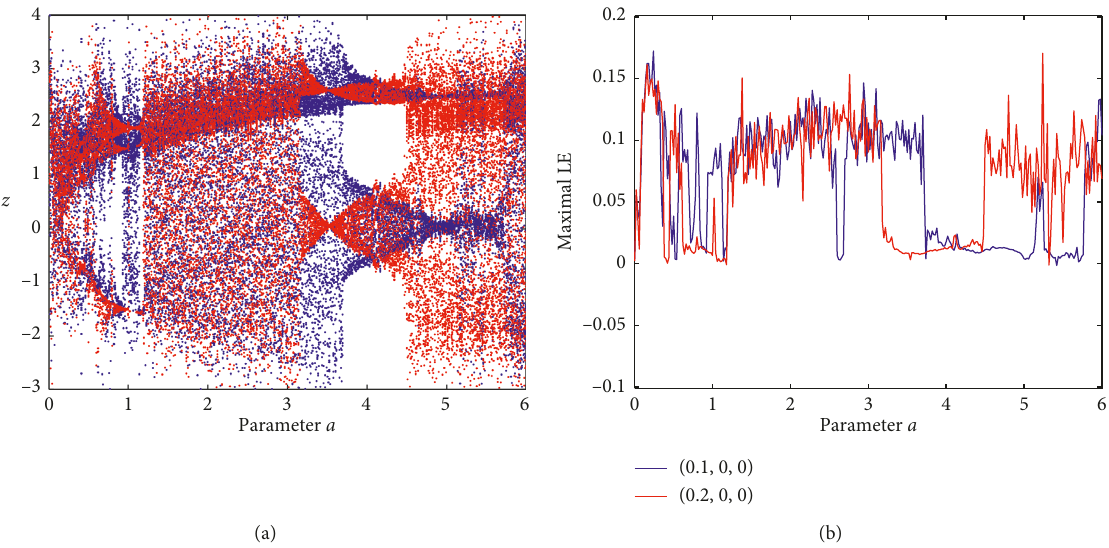
Figure 2: (a) Bifurcation diagrams and (b) spectrums of maximal Lyapunov exponent versus parameter a , the initial conditions are (0.1, 0, 0) for blue diagrams and (0.2, 0, 0) for red